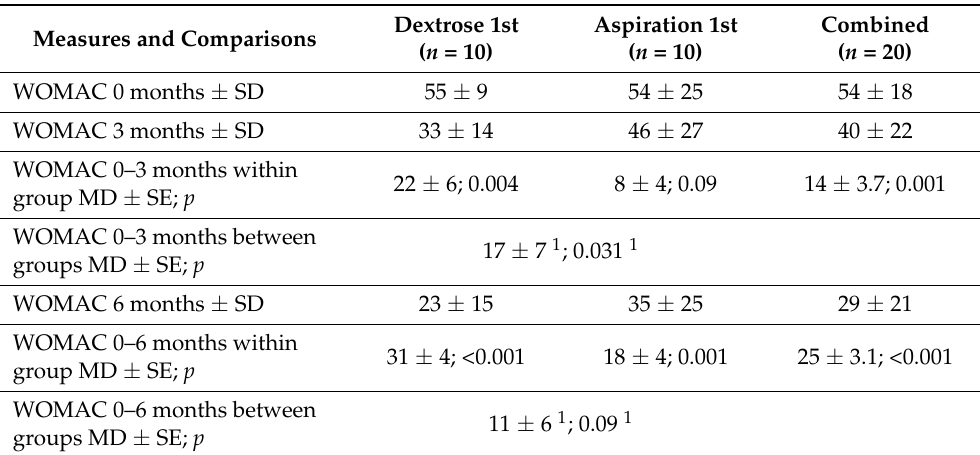
Figure 3. Change in the mean WOMAC score from time 0 through 6 months for combined groups (n = 20) with MCID levels indicated. Table 5. Changes in the WOMAC scores.